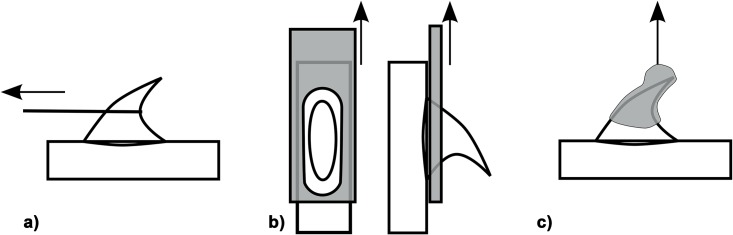
Types of mechanical tests.Mechanical tests were performed with a) traction applied via a Kevlar loop resulting in a combination of bending and shear stresses (Rosa prickles and Asparagus spines), b) traction parallel to the stem applied at the base of the hook via perforated aluminium plates (Rosa arvensis ‘Splendens‘ type II prickles, resulting in pure shear stresses) and c) traction perpendicular to the stem and applied to the whole Rosa prickle, resulting in pure tension stress.